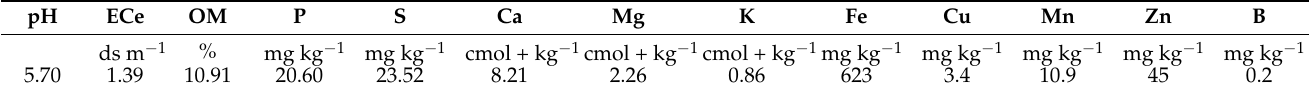
Table 3. Chemical characteristics of the soil in the experimental site.